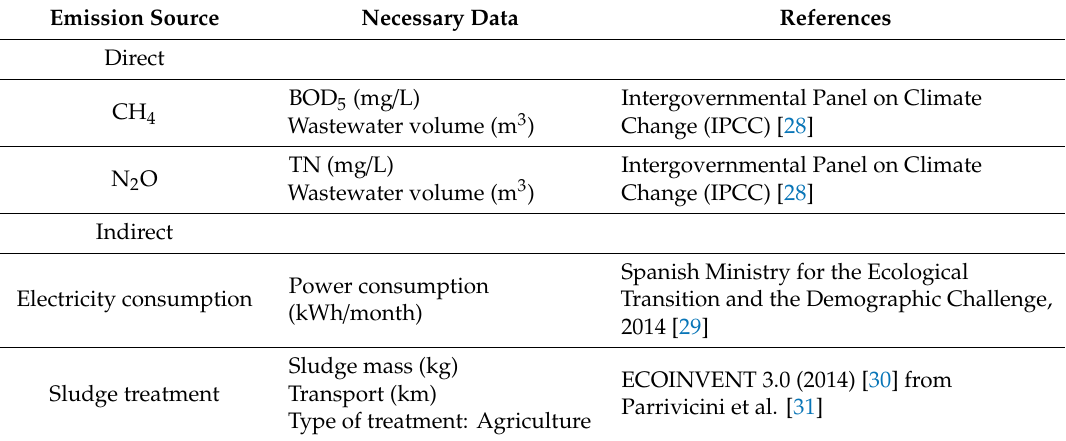
Table 1. Data to evaluate carbon footprint. BOD 5 , biochemical oxygen demand at five days; TN, total